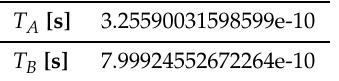
Table 4. T A and T B values derived through a mean square error (MSE) interpolation.